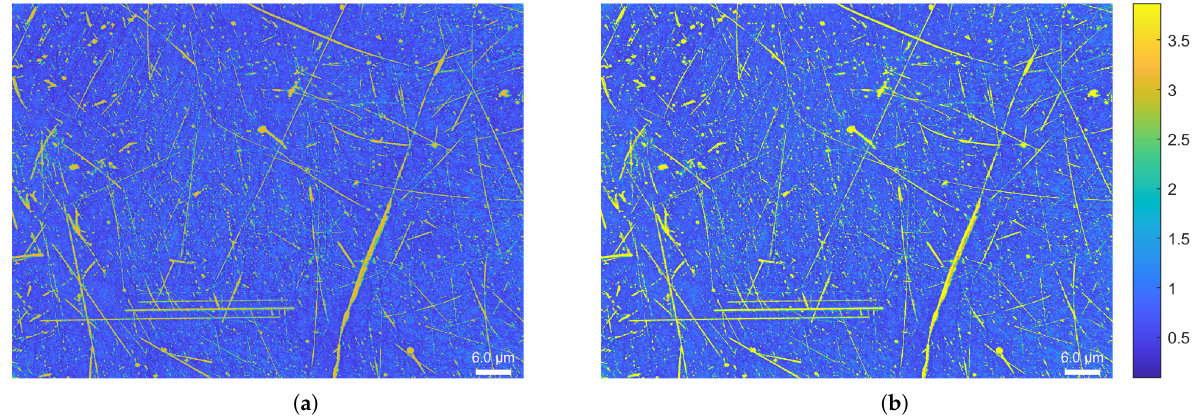
Figure 12. Multi-level and multi-scale saliency maps estimated with the statistics descriptors cal- culated from an RTI acquisition of the watch dial: ( a ) Saliency map multi-scale; ( b ) Saliency map multi-scale